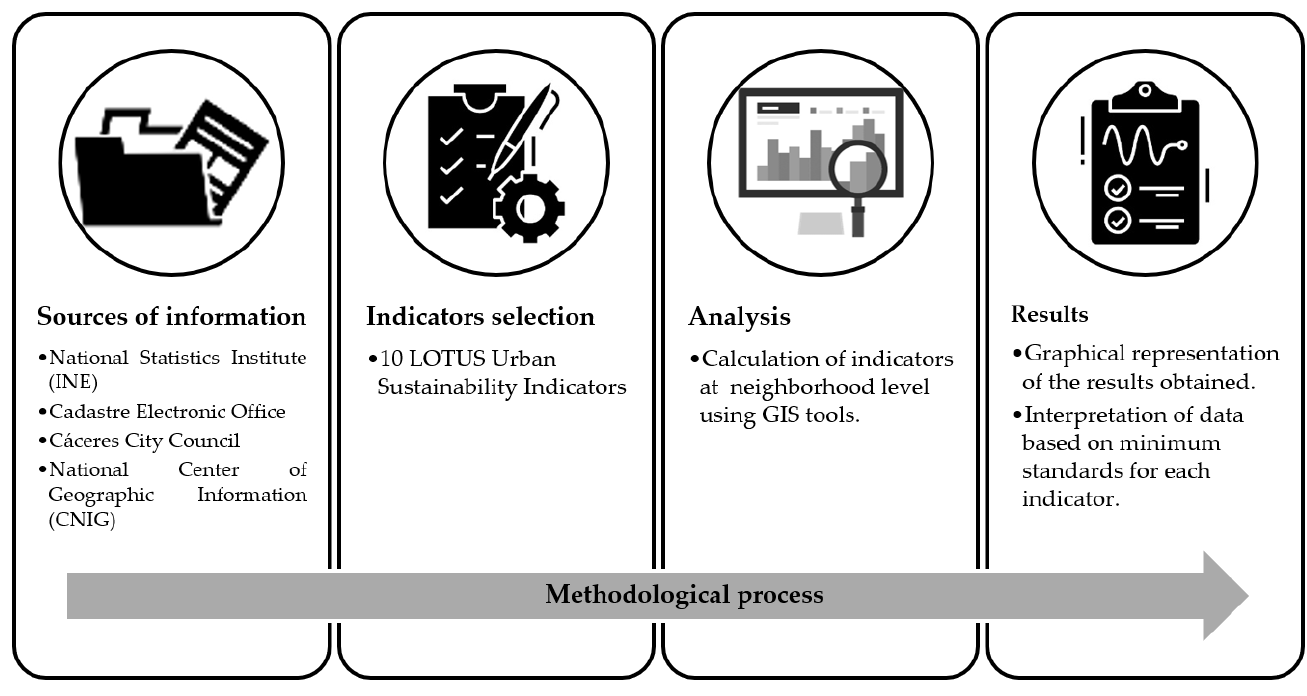
Figure 3. Methodology flowchart. Table 1. Selected sustainability indicators